Question: Which kind of chart has been used to present this data?
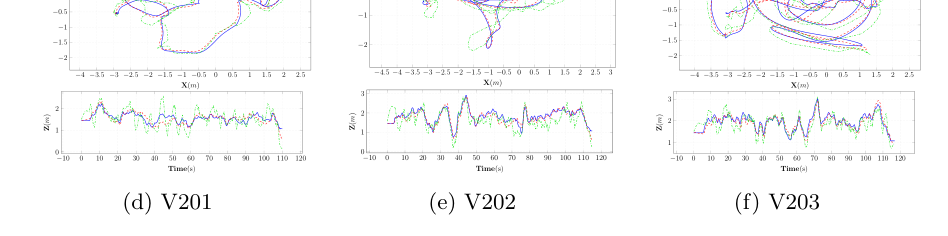
Answer: line